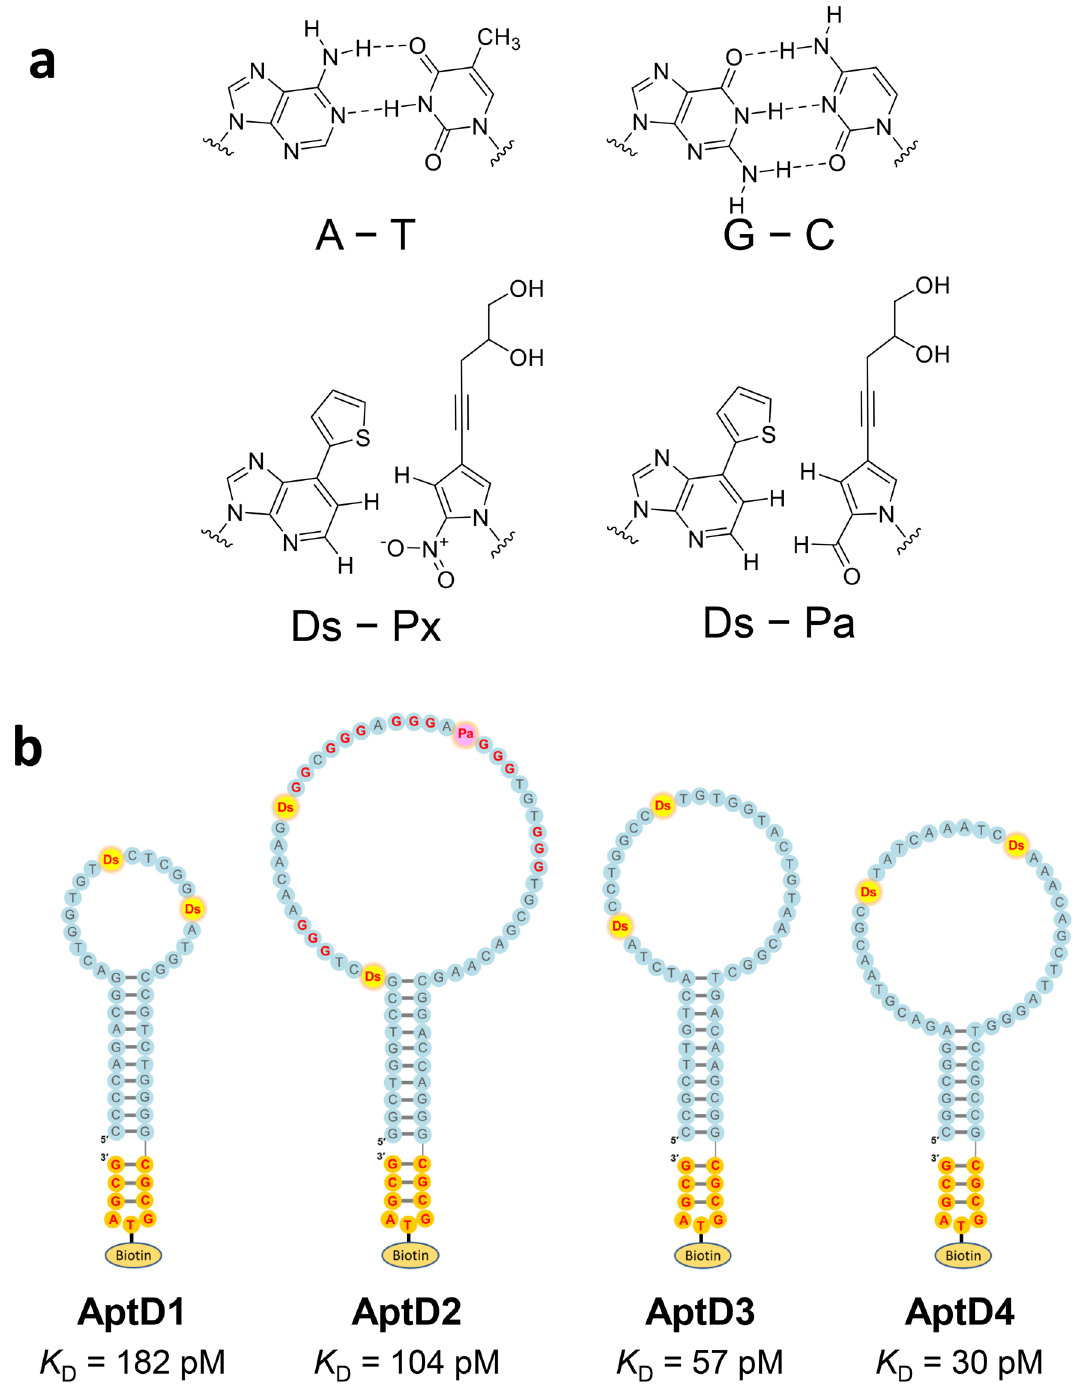
Figure 2. Natural and unnatural base pairs for UB-DNA aptamer generation and anti-DEN-NS1 UB-DNA aptamers. (a) Chemical structures of the natural base pairs, A–T and G–C, and the unnatural base pairs, Ds–Px and Ds–Pa. (b) Presumed secondary structures of UB-DNA aptamers that bind specifically to each serotype DEN-NS1: AptD1 to DEN1-NS1, AptD2 to DEN2-NS1, AptD3 to DEN3-NS1, and AptD4 to DEN4-NS1. Each aptamer’s dissociation constant ( K D ) determined by SPR analysis is shown. The unnatural Ds and Pa bases are shown in yellow and pink circles. At each aptamer’s 3 ′ -terminus, the stable mini-hairpin sequence (CGCG(Bio-T)AGCG) is attached for stabilization against heat and nucleases and to introduce the biotinylated T (Bio-T) for aptamer